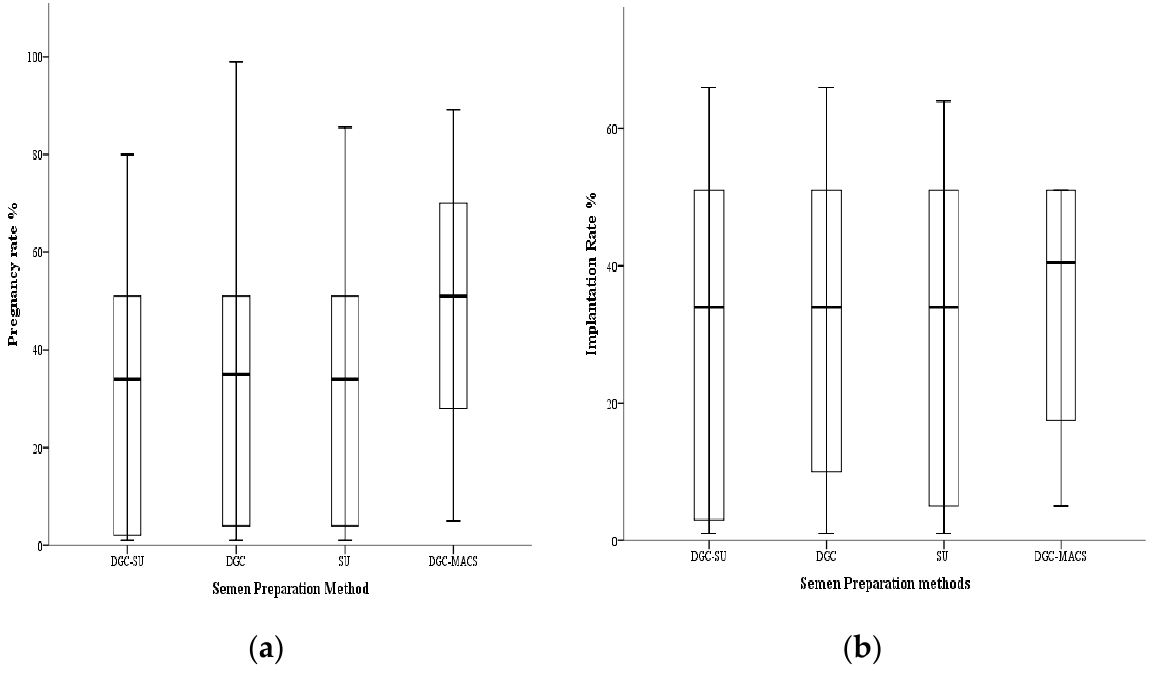
Figure 3. Box plot showing clinical ( a ) pregnancy rate and ( b ) implantation rate in couples in which semen preparation was done using the DGC-SU, DGC, SU and DGC-MACS methods.